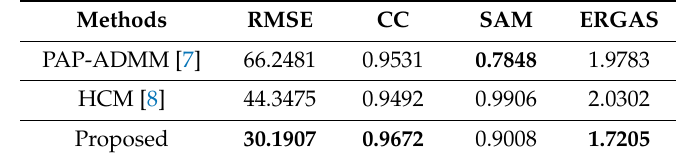
Table 1. Comparison of various methods of HCM and PAP-ADMM on AVIRIS. Bold numbers indicate the best algorithm for each metric.